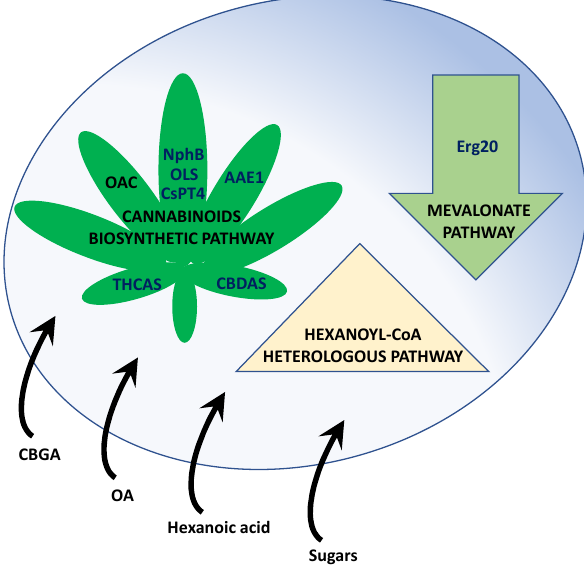
Figure 2. Main pathways engineered in yeasts in order to produce cannabinoids from different precursors. Abbreviations: AAE1, acyl activating enzyme; CBDAS, cannabidiolic acid synthase; CBGA, cannabigerolic acid; CBGAS, CBGA synthase; CsPT4, C. sativa prenyltransferase 4; Erg20, GPP synthase; NphB, aromatic prenyltransferase from Streptomyces sp. CL190 strain; OA, olivetolic acid; OAC, OA cyclase; OLS, olivetol synthase; THCAS, Δ 9 -tetrahydrocannabinolic acid synthase.